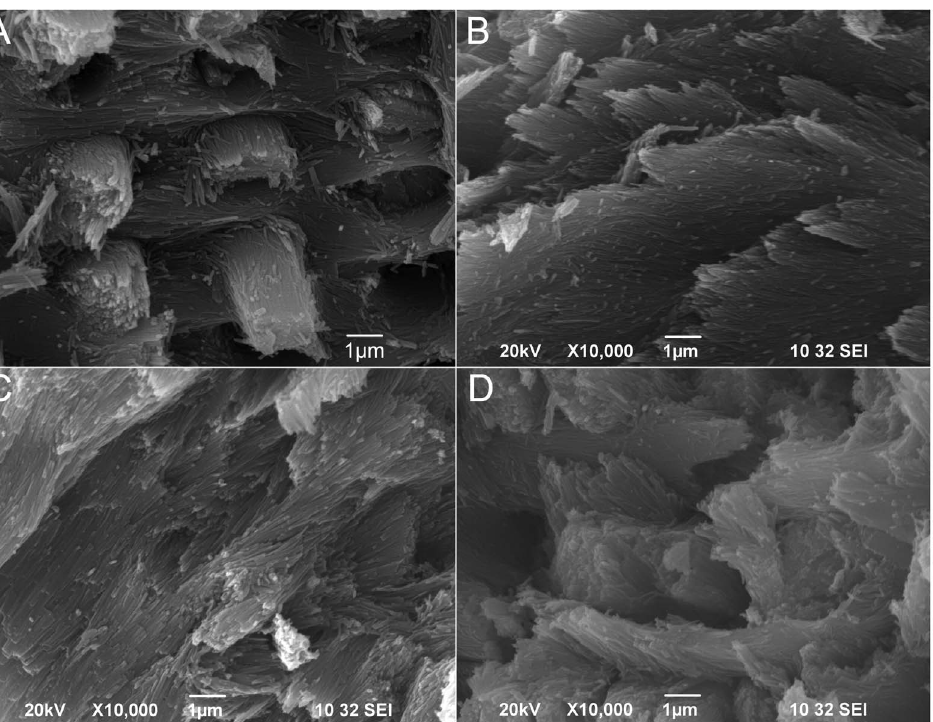
Figure 4. Scanning electron microscope (SEM) images of tooth enamel. Teeth were cracked open with a diamond knife and then coated with gold/platinum for SEM observation. Panel A is taken from a normal (wild-type) incisor taken from a mature NBCe1 + / + animal. Panels B, C and D are taken from the NBCe1 + / + , NBCe1 + / 2 and NBCe1 2 / 2 teeth, respectively, grown in the kidney capsule. Scale bars are included in each panel.